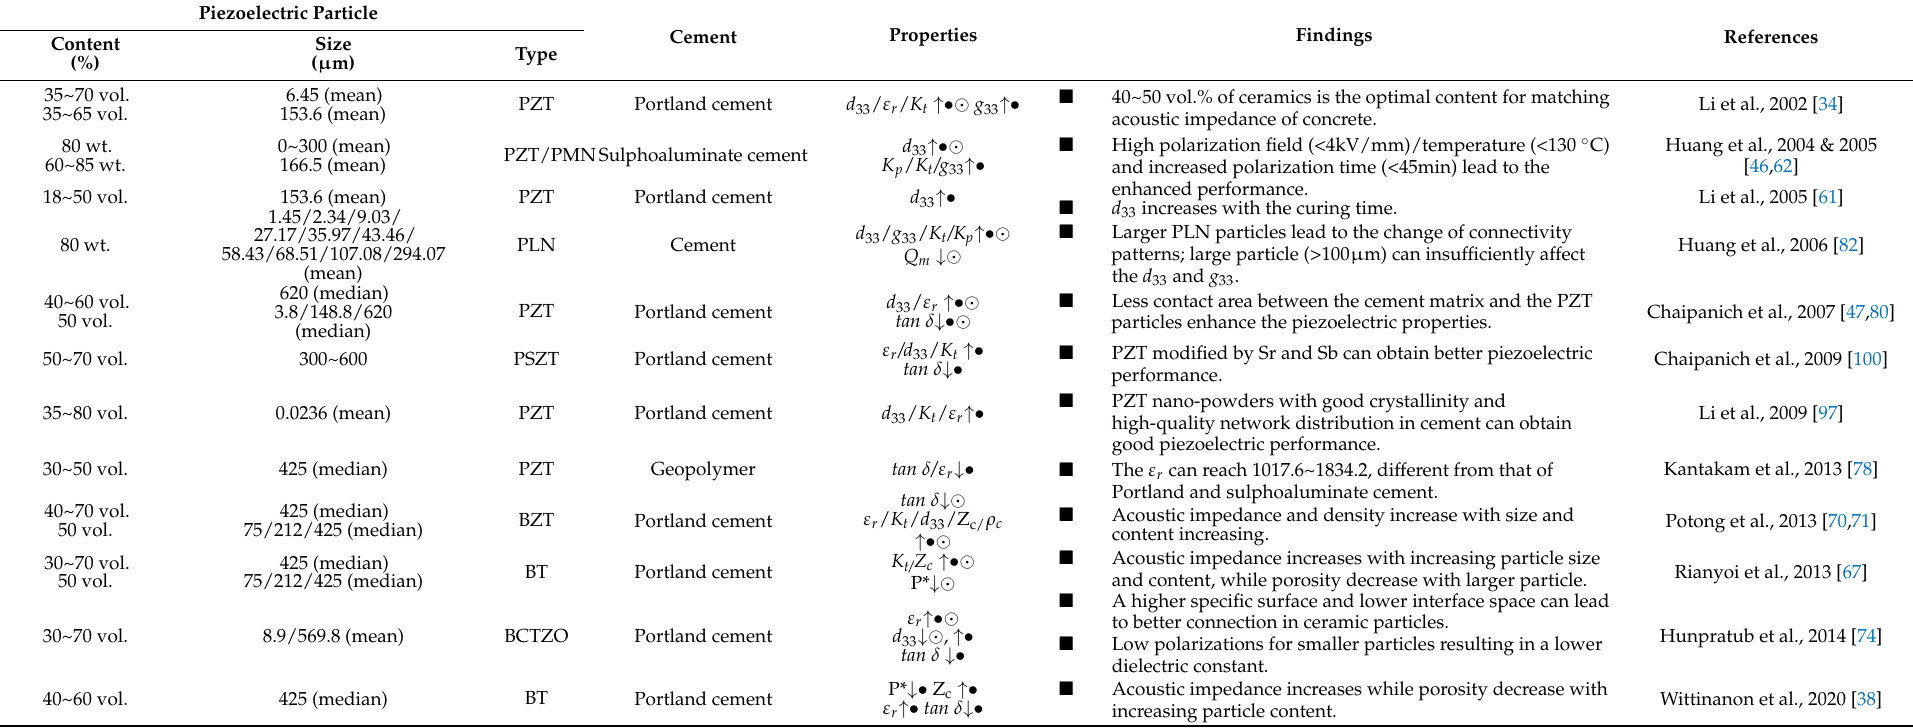
Table 3. Properties of cement-based piezoelectric composites with different piezoelectric ceramic particles content and size. Piezoelectric